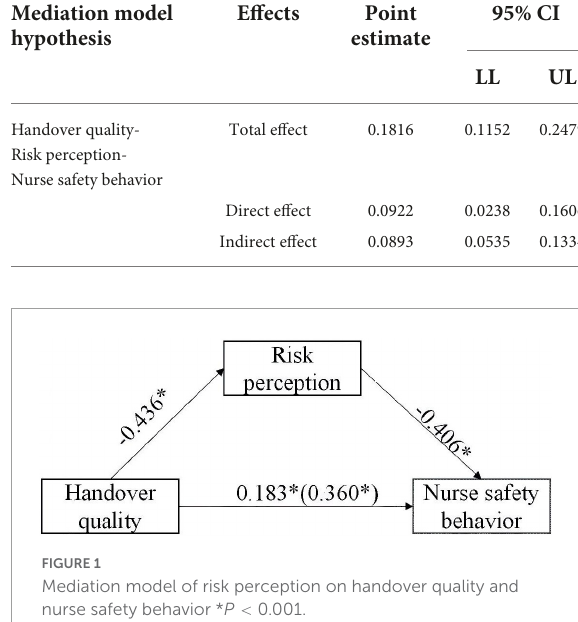
TABLE 2 Mean, standard deviations (SD), and correlation of variables ( r ).